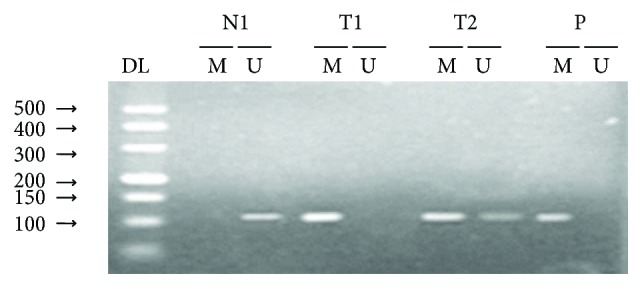
Methylation status of Wnt5a in normal ovarian tissues and epithelial ovarian carcinomas. N: normal ovarian tissues; T: epithelial ovarian carcinomas; P: positive control; DL500: DNA marker; M: methylation; U: unmethylated.